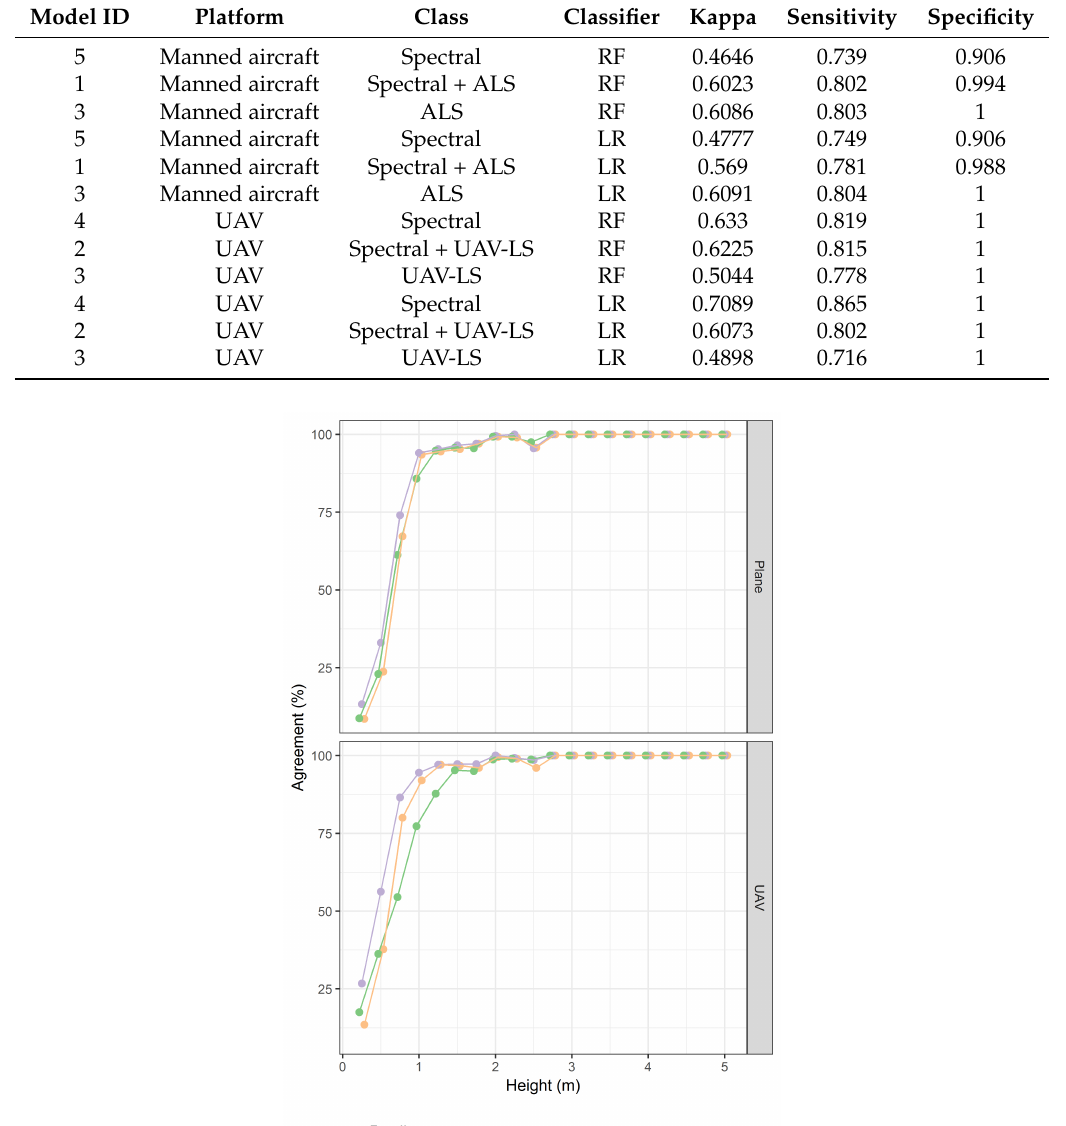
Table 4. Summary of the independent validation of model predictions. Model identifiers (Model ID) are as specified in Table 1.